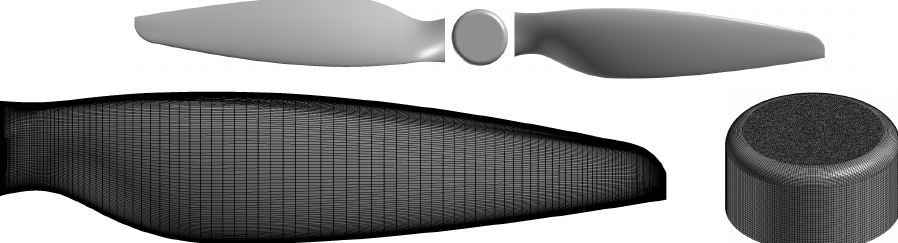
Figure 3. Computational model of the counter-clockwise rotor showing: top view of the rotor model demonstrating the separation from the hub and blade root, top view of a single blade mesh, and oblique view of the hub